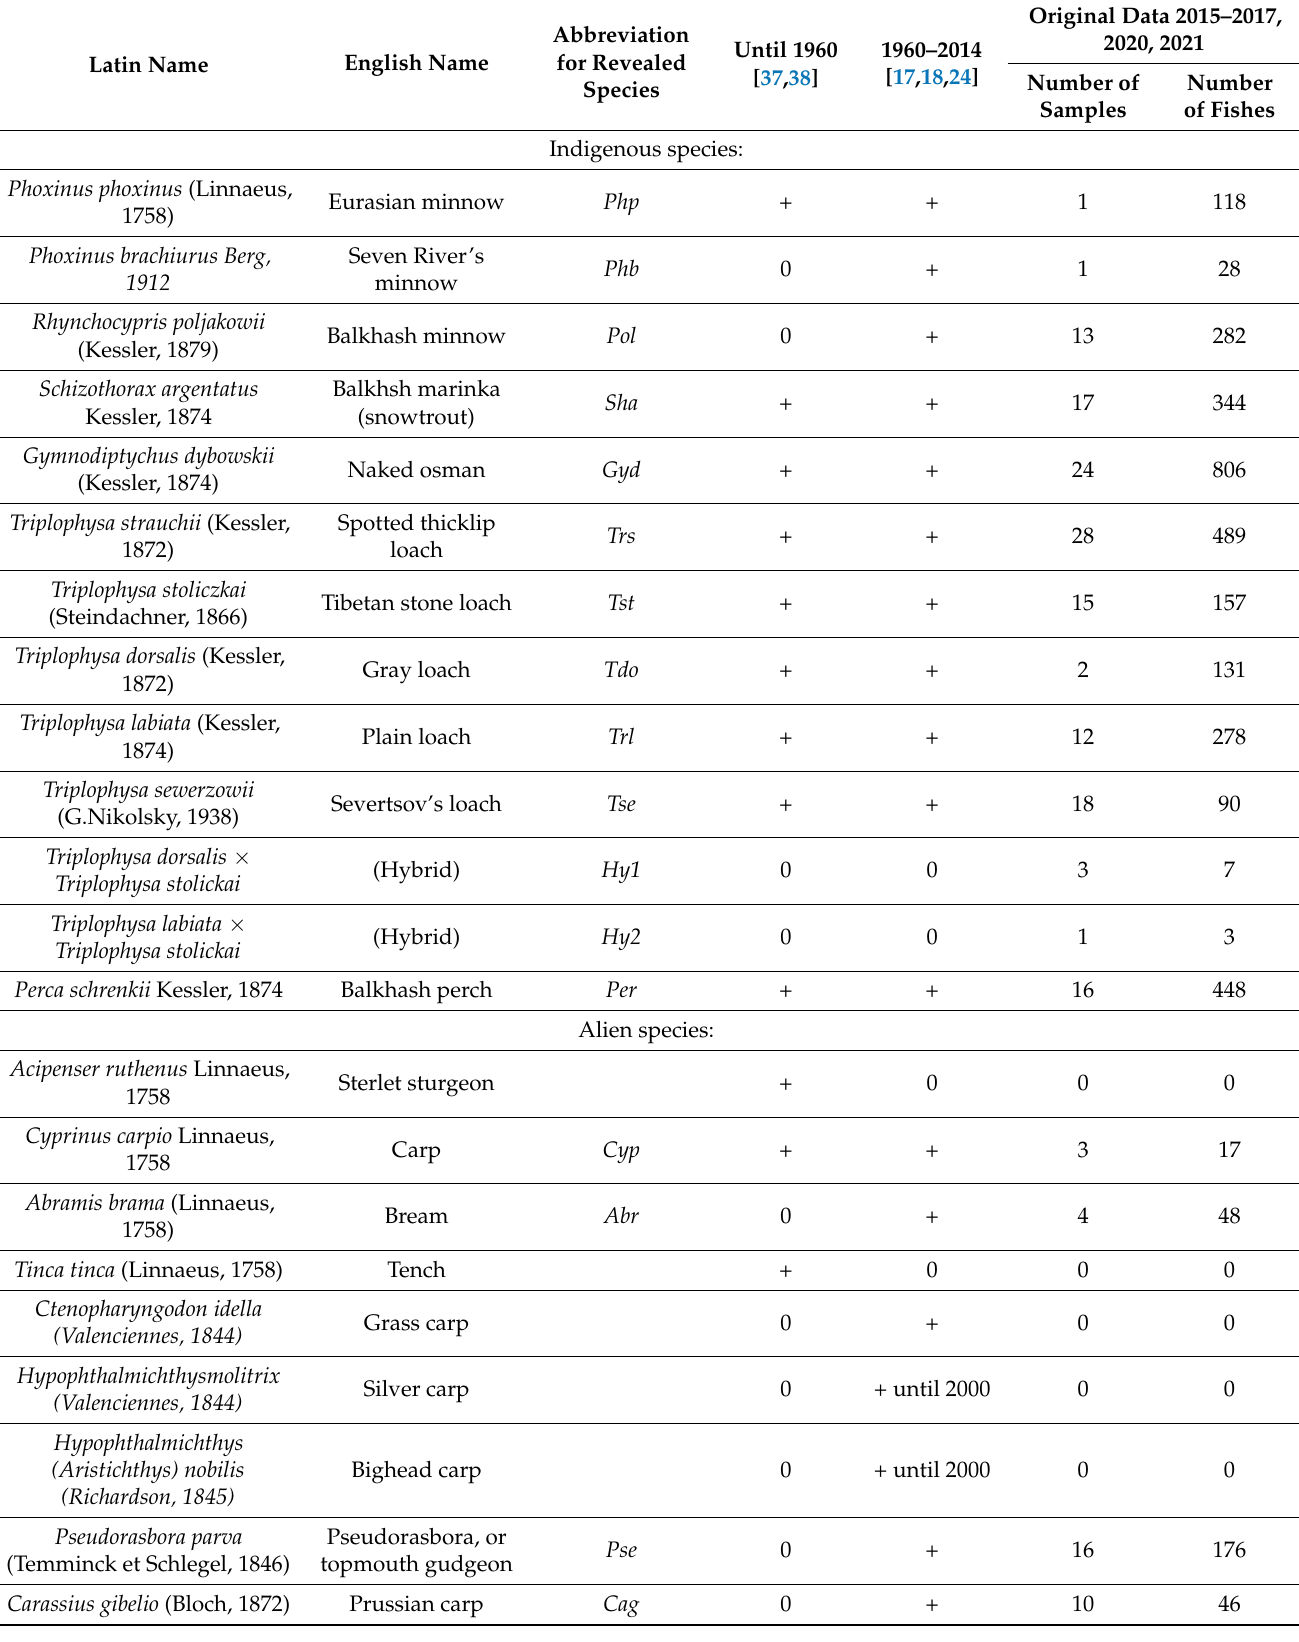
Table 3. Fish diversity changes over